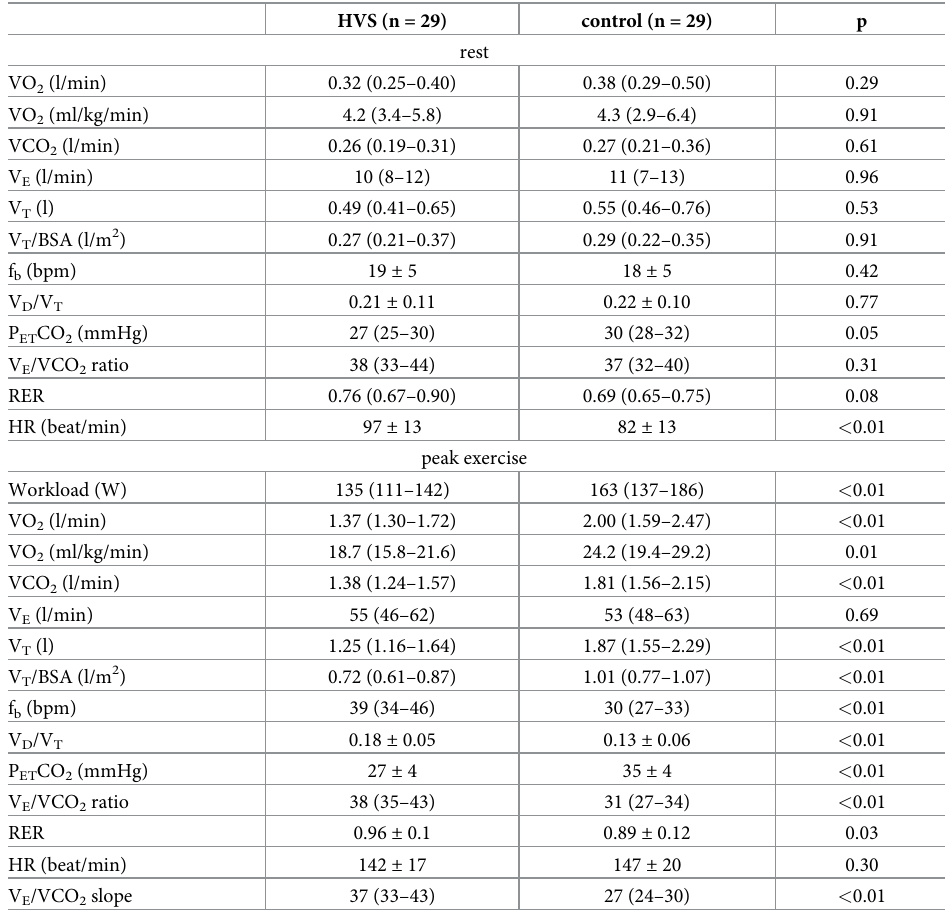
Table 2. Cardiopulmonary exercise